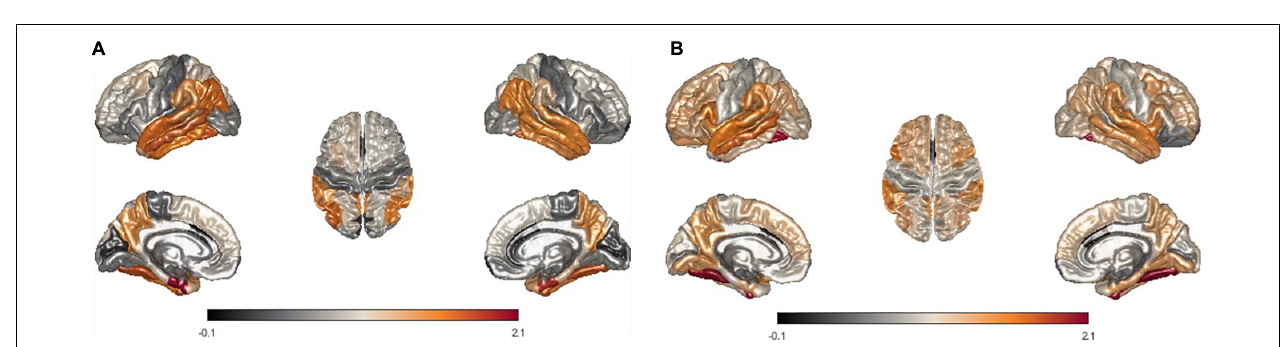
FIGURE 4 | Each line plot represents the root mean square error (RMSE) between the Self-W and LME-W of the datasets. In the experiment, all LME models that were used to calculate the LME-W of a dataset were trained without the corresponding dataset. The red dot line represents the fitted linear plot of average RMSE over all datasets.